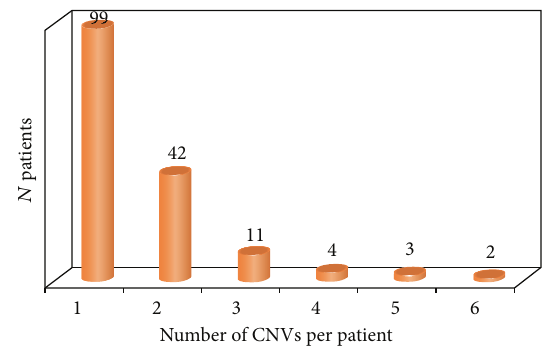
Figure 2: Individual incidence of CNV affecting genes implicated in the cell cycle